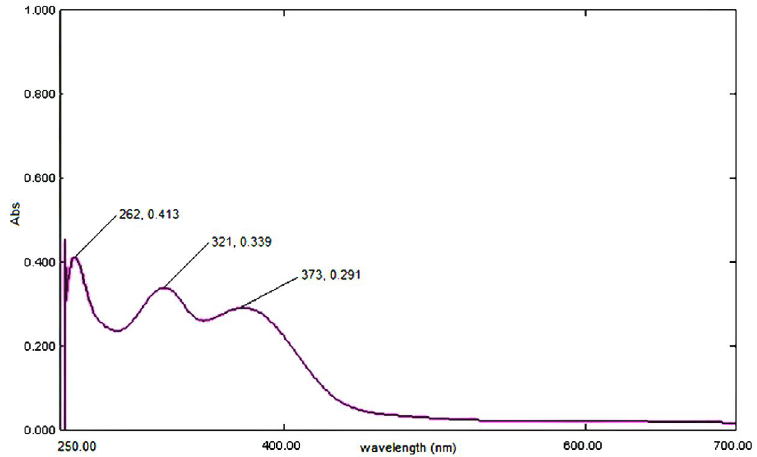
Figure 4. UV/Vis spectrum of the polymer P o HOBPD conditions as experimental Table 2. Results of spectrophotometric studies of monomers and polymers in DMSO Solvent S. No Compound λ nm (ε 1%)